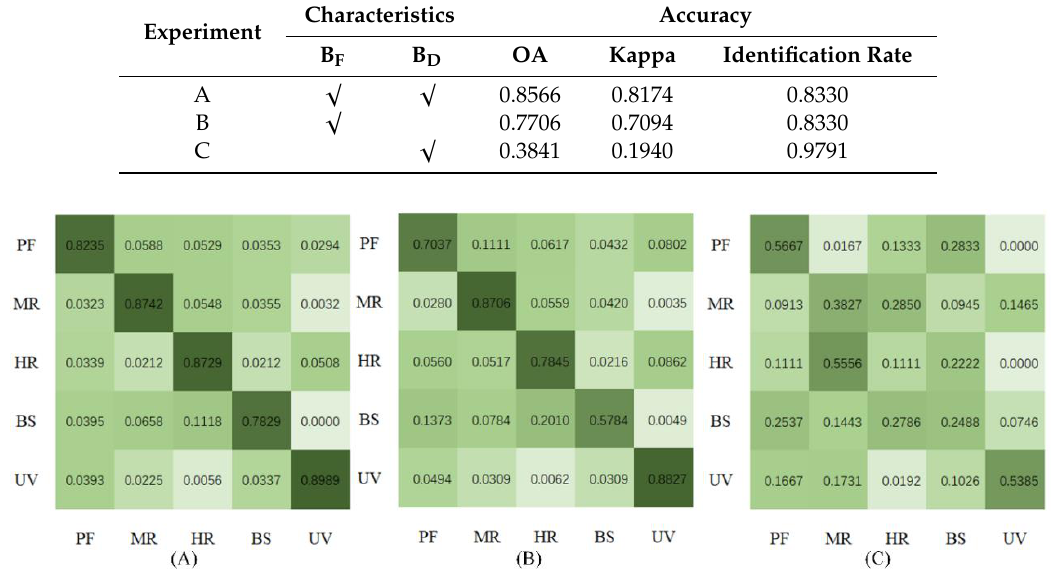
Table 3. Overall building recognition rate based on different characteristics.